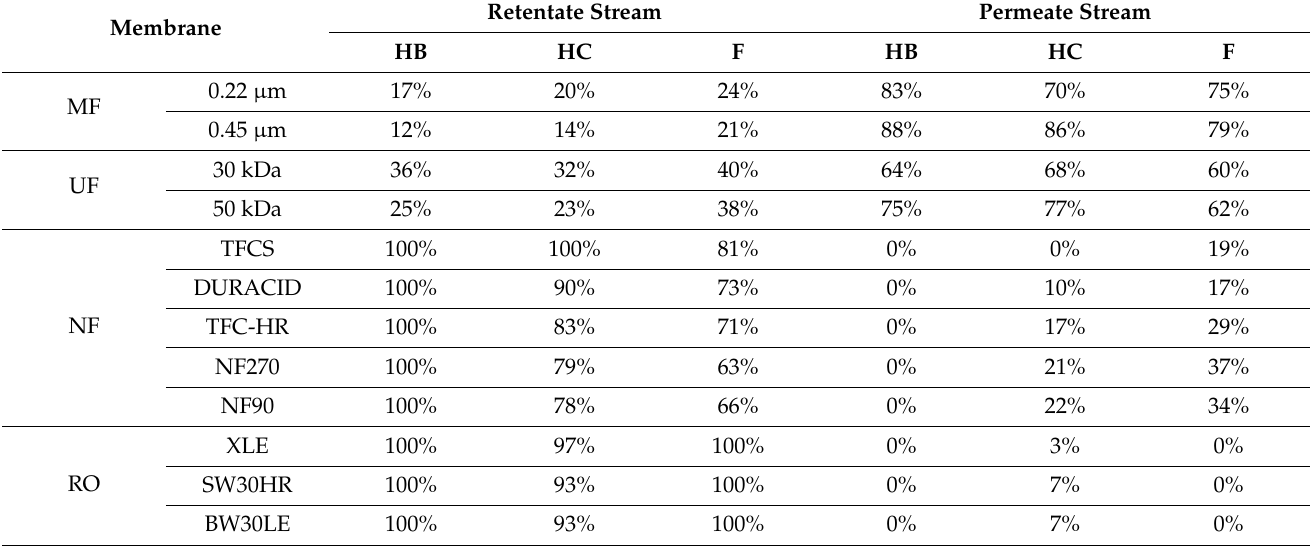
Figure 2. MF (0.22 and 0.45 µ m) rejection evolution with permeate flux of spinach and orange matrices ( a , b ), respectively. Table 2. Results of the rejection of each polyphenol family obtained with spinach extracts for the MF, UF, NF, and RO membranes (means of the two